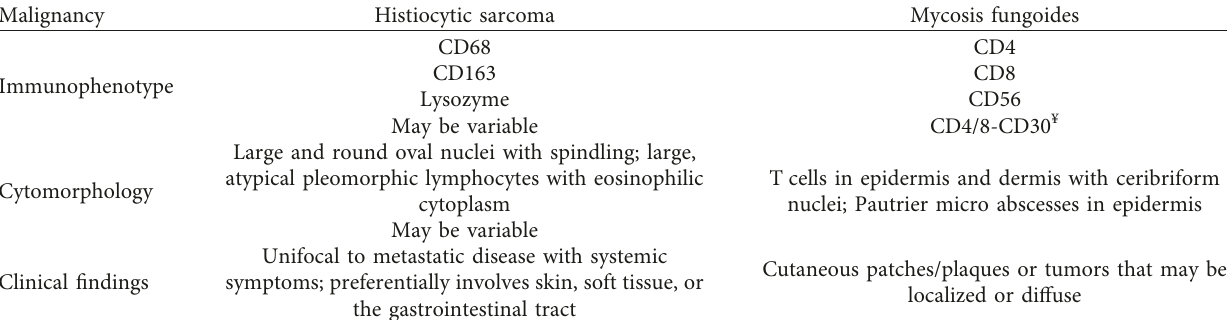
Table 1: A comparison of the immunophenotypic, cytomorphologic, and clinical findings of HS and MF. Malignancy